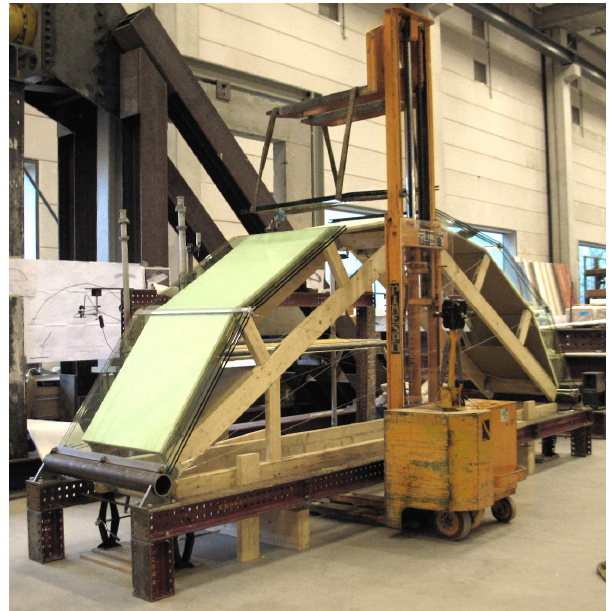
Figure 14: Constructing the prototype for